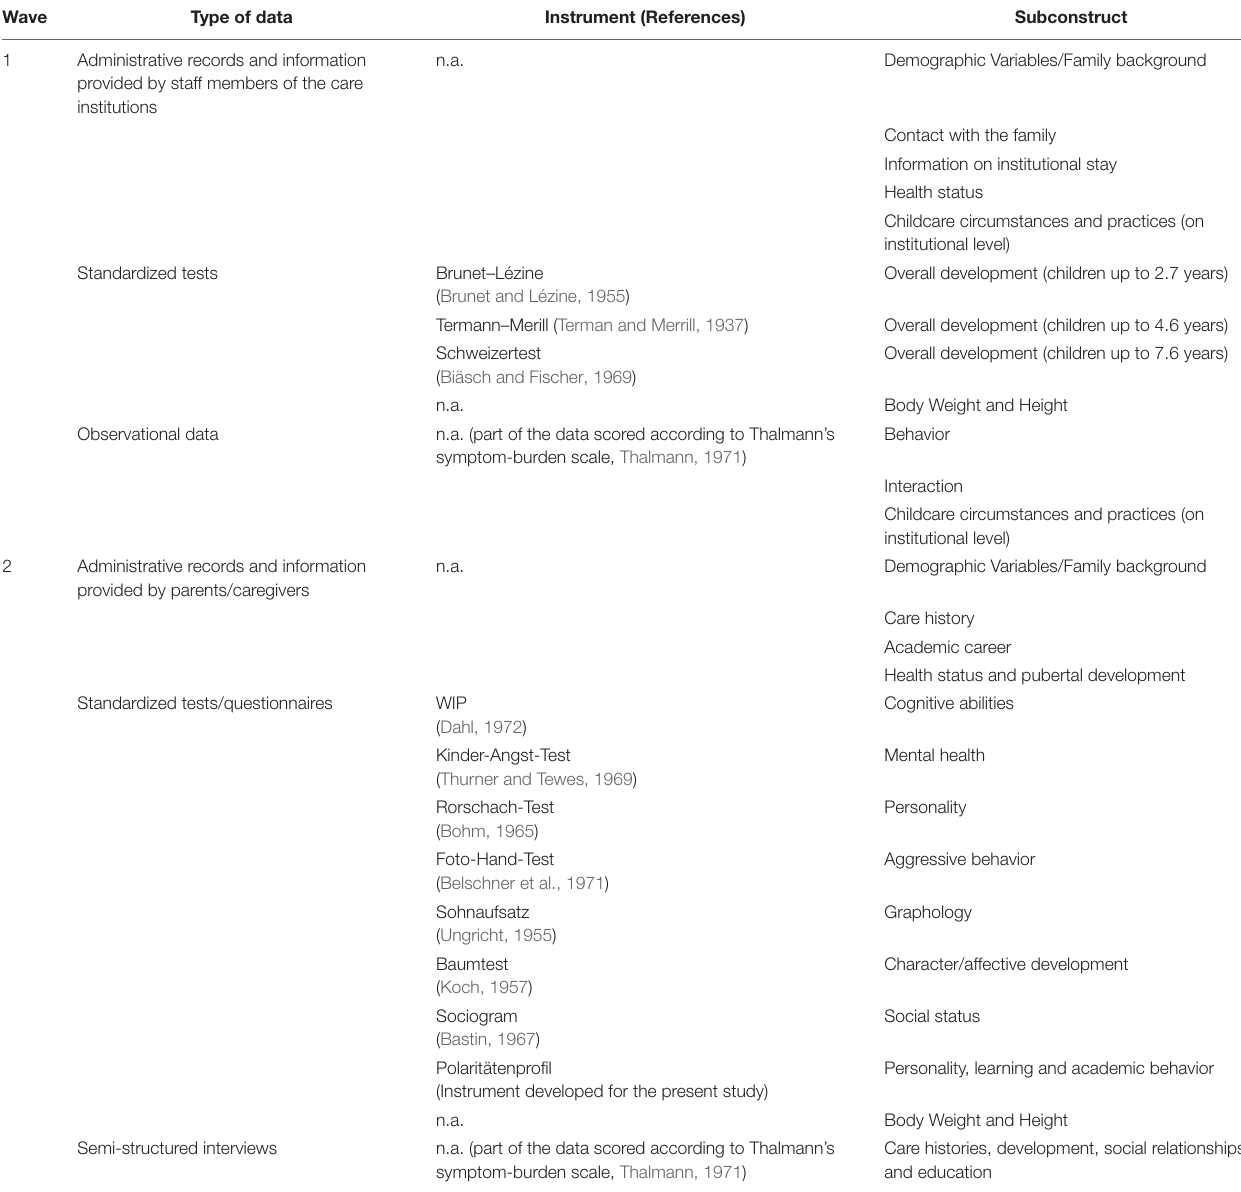
TABLE 1 | Overview of the assessment instruments (Wave 1 and